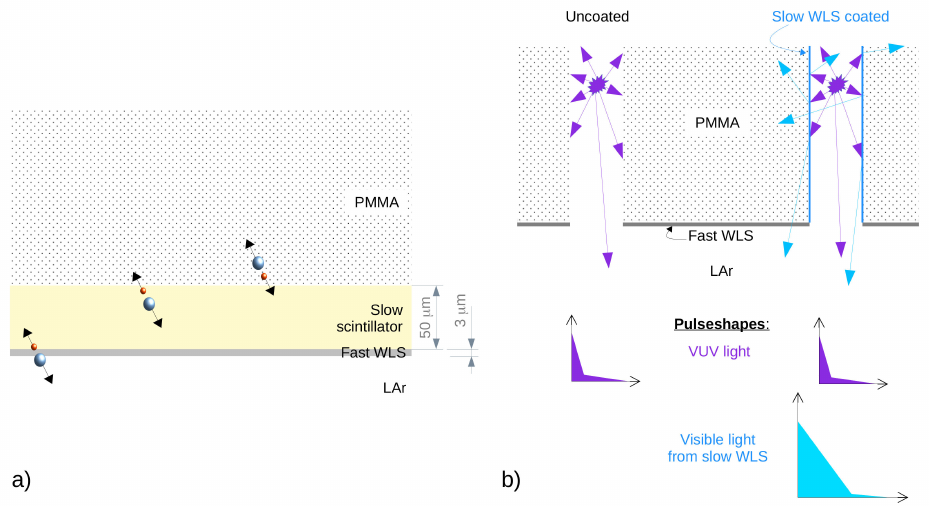
Figure 4. WLS-based background mitigation schemes: ( a ) WLS-coated slow scintillator on a passive PMMA detector wall. Alpha decays will either deposit all of their energy in an active region (LAr, WLS or the scintillator) and be discriminated based on high deposited energy, or will deposit only a fraction of their energy in the slow scintillator, in which case they can be discriminated against based on its long decay time [123]. ( b ) Slow WLS coating. Alpha decays occurring in a slit in the detector wall can induce a fake low-energy background event, as most of the VUV scintillation is absorbed before entering the main volume ( left ). In the presence of the slow WLS in the slit ( right ), the event will be dominated by visible photons converted in the slow WLS and could be removed with